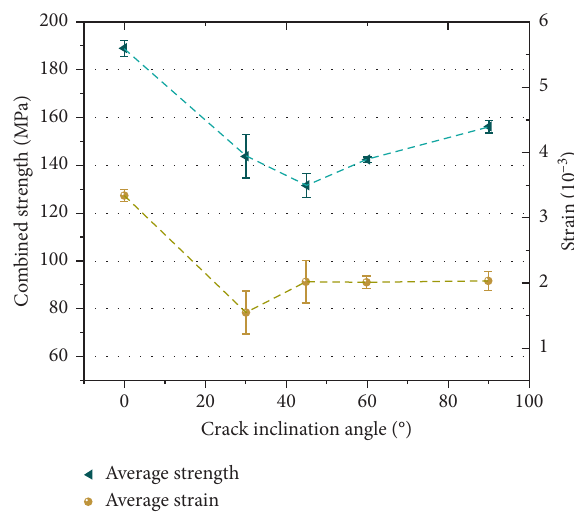
Figure 6: The relationship between combined strength/peak strain and the flaw inclination